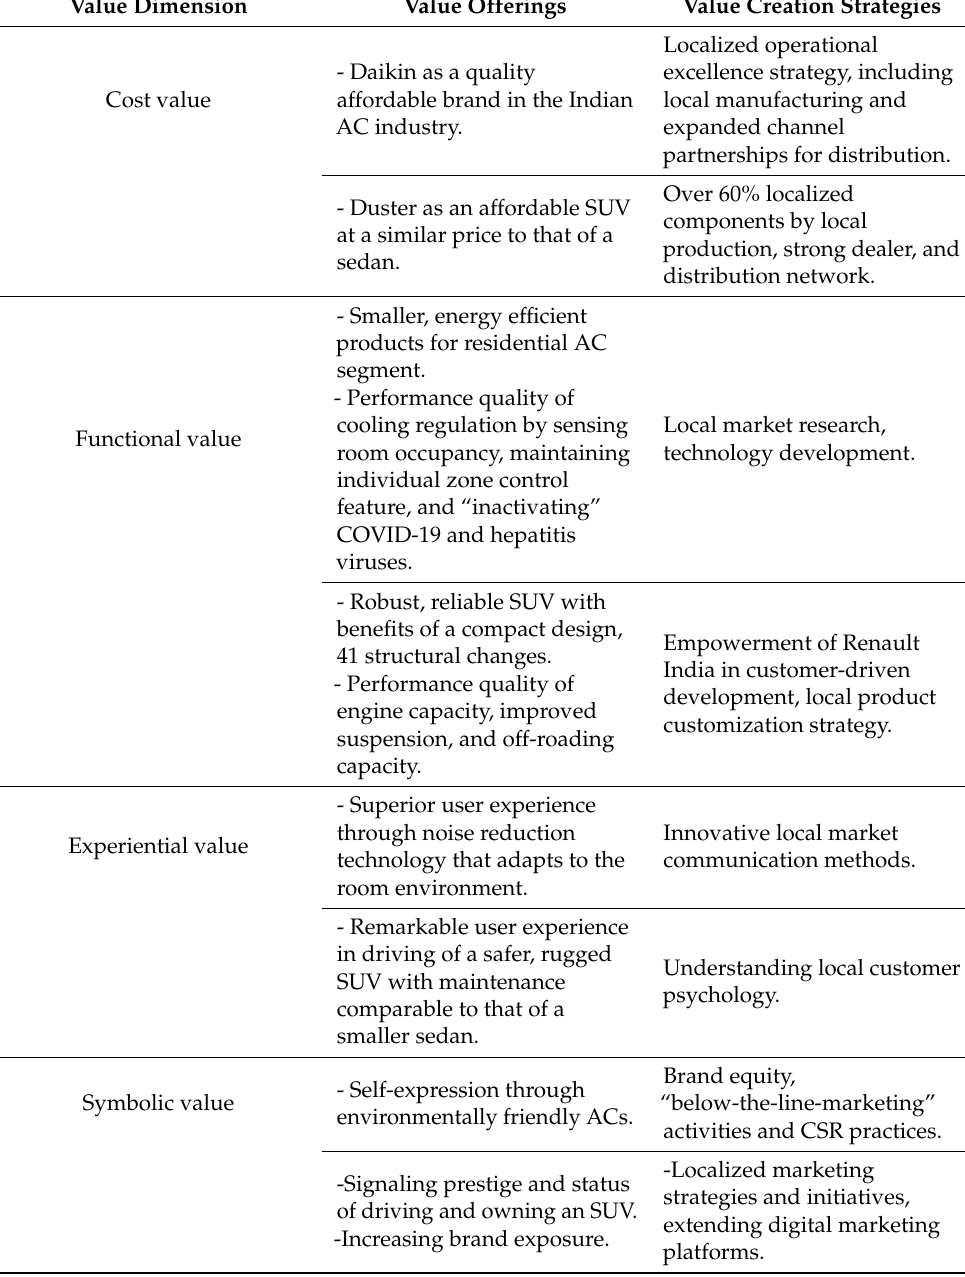
Table 1. Value offerings and value creation strategies of Daikin and